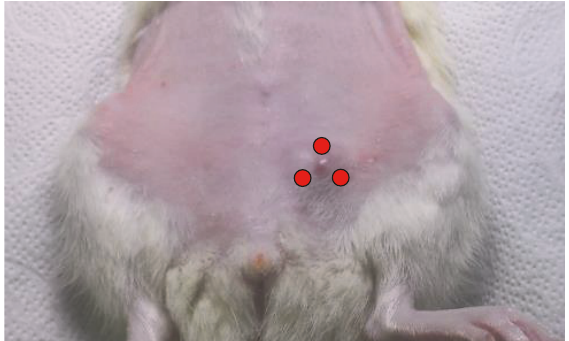
Figure 4: An example of shaved and depilated animal. Among eight nipples, one abdominal nipple with breast tumor was monitored in the study. Raman signals were measured in triangular shape around a tumor (red colored dots). Below the right nipple, breast cancer cells ( ~ 1 million) were inoculated into mammary fat pad